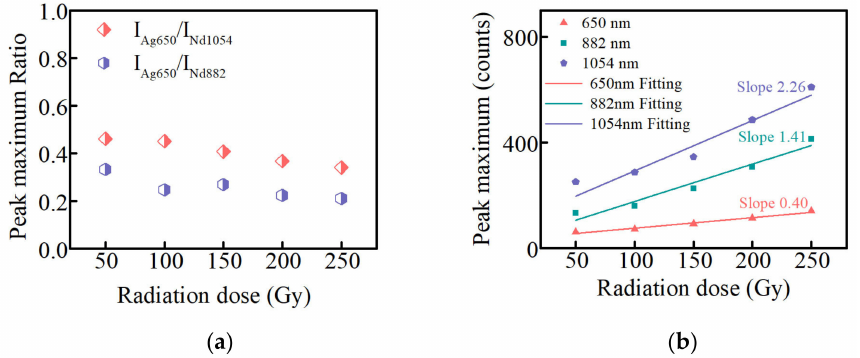
Figure 8. ( a ) the peak maximum ratio of the Ag defect center at 650 nm compared to that of Nd 3+ ions at 882 and 1054 nm at different radiation doses; ( b ) the linear relationship between the RPL peak maximum intensity of Ag defect centers at 650 nm and the fluorescence peak maximum intensity of Nd 3+ ions at 882 and 1054 nm and the radiation dose in Ag–Nd-codoped phosphate glasses (380 nm